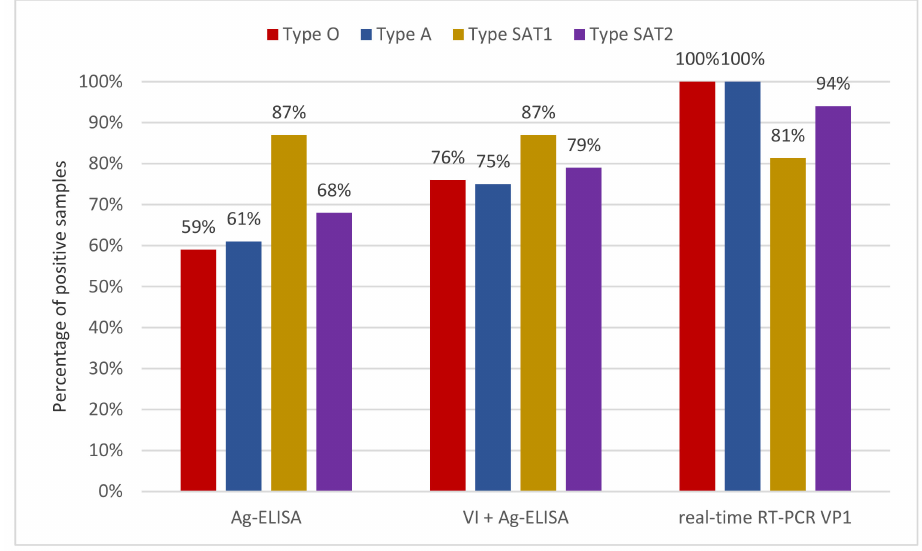
Figure 1. Serotyping performances of three assays, calculated as the proportion of samples correctly typed. From the left, Ag-ELISA on tissue homogenates (Ag-ELISA); VI and subsequent Ag-ELISA (VI+ following Ag-ELISA); and topotype-specific real-time RT-PCRs targeted on VP1 (real-time RT-PCR VP1). Results are shown by serotype: in red type O, in blue type A, in yellow type SAT1, and in purple type SAT2, according to the colour scheme proposed by by the World Reference Laboratory for Foot-and-Mouth Disease. Percentages are calculated based on the cumulative number of FMDV samples positive for each serotype (including the samples positive for two serotypes): 29 for type O, 44 for type A, 32 for type SAT1, and 19 for type SAT2. Topotype-specific real-time RT-PCRs showed the best sensitivity among assays, except for the SAT1-specific reaction, which had lower